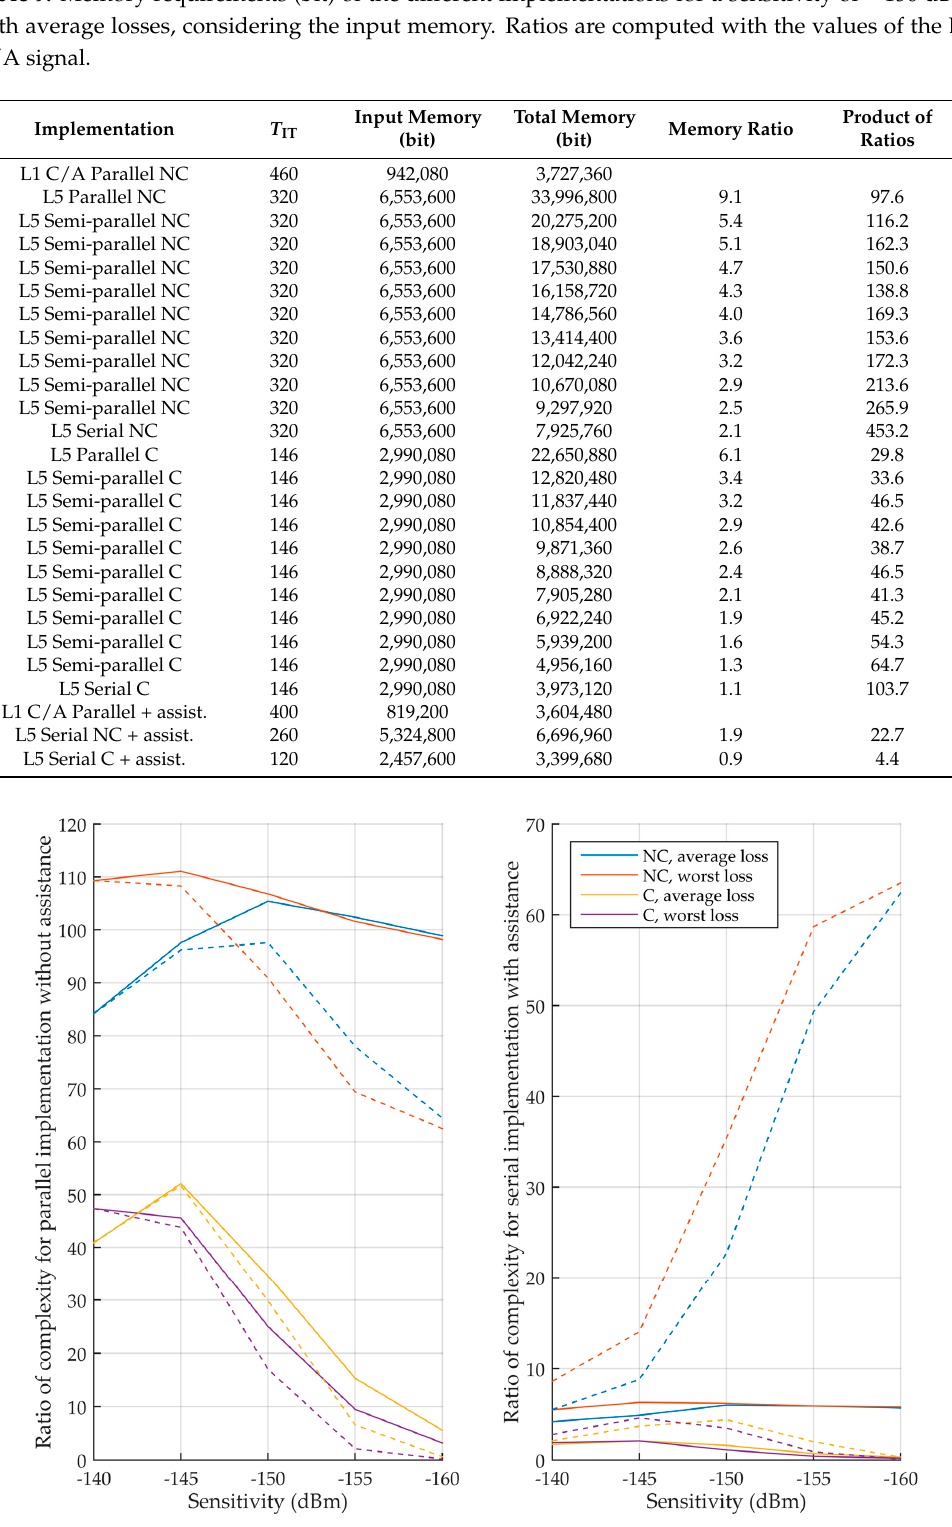
Figure 12. Ratio of complexity (product of processing time ratio and memory ratio) between the L5 and L1 C/A signals. ( Left ) without assistance, ( right ) with assistance. Solid curves do not consider the input memory, while dashed curves consider the input memory. Table 10. Ratio of complexity (product of processing time ratio and memory ratio) between the L5 and L1 C/A signals. Top rows do not consider the input memory, while bottom rows consider the input memory.